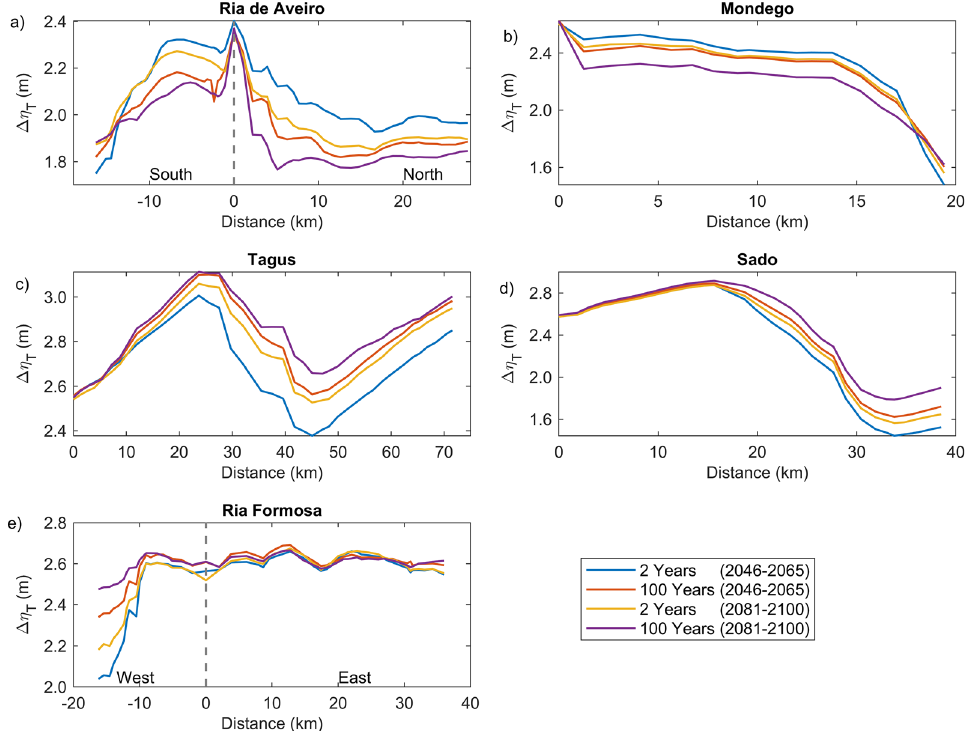
Figure 8. Variation of the water level range ( �η T ) along a transect starting at the estuary or lagoon mouth: ( a ) Ria de Aveiro, ( b ) Mondego, ( c ) Tagus, ( d ) Sado and ( e ) Ria Formosa. Each transect is represented by pink dots in supplementary Figs. S1, S2, S3, S4 and S5.